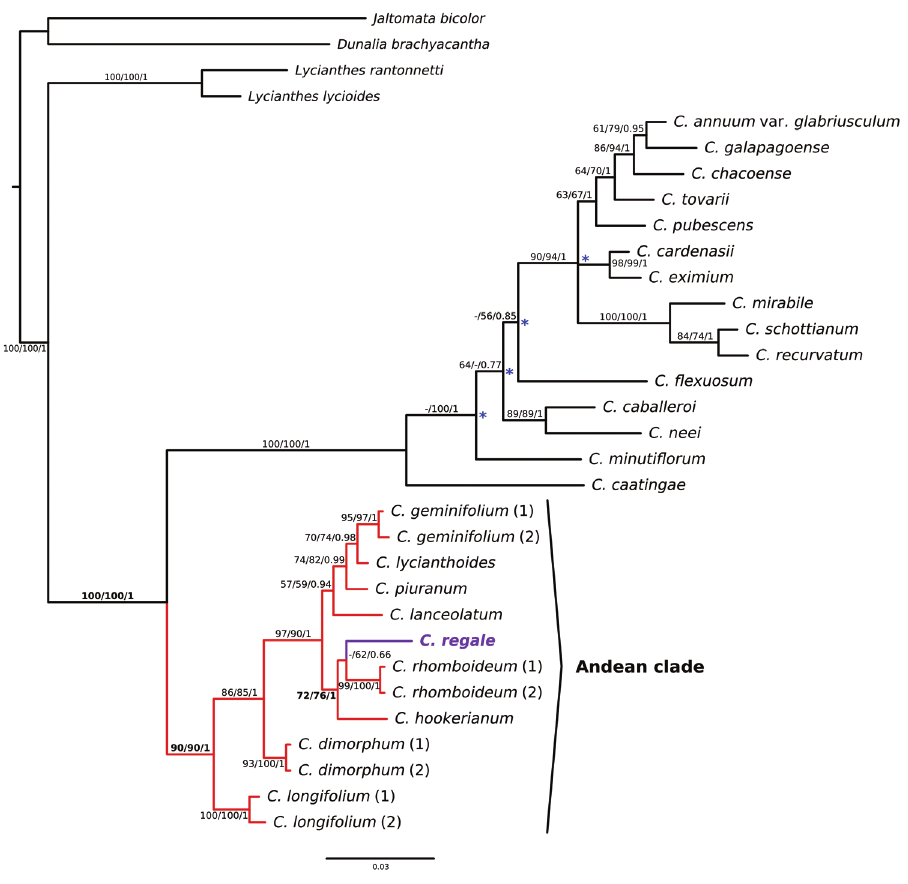
Figure 6. Bayesian majority-rule consensus tree of Capsicum showing the placement of C. regale Barboza & Bohs. The Andean clade is highlighted in colored branches. Support values are indicated by each branch (bootstrap support maximum parsimony/bootstrap support maximum likelihood/posterior probabilities; dashes indicate support values < 50%). Key support values that indicate the position of C. regale are shown in bold. Asterisks indicate different resolutions using maximum